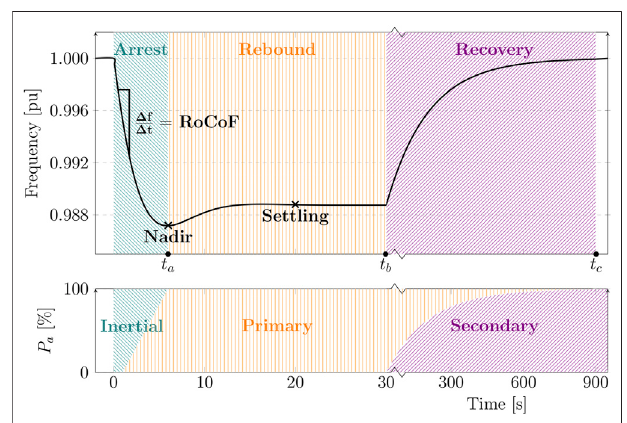
FIGURE 2 | Three periods of frequency variation (arrest, rebound, and recovery) and control actions (inertial, primary, and secondary) following a perturbation caused by lack of